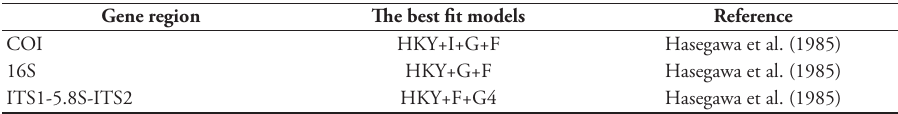
Table 3. The best models of Bayesian phylogenomic